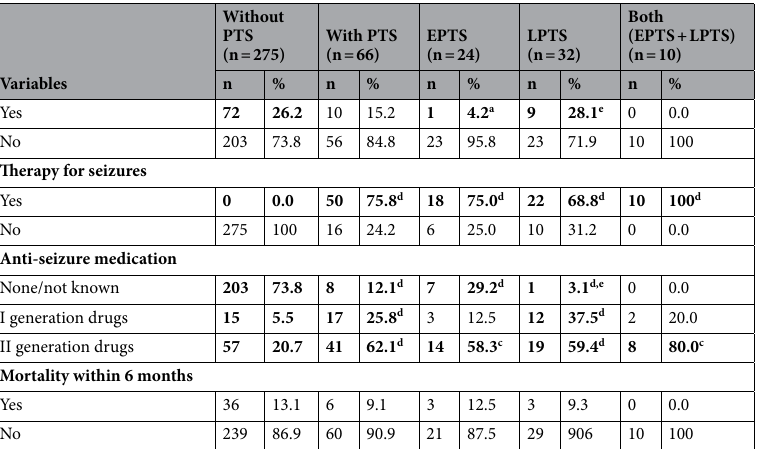
Table 2. Comparison of traumatic brain injury (TBI) patients without vs. with post-traumatic seizures (PTS), and between patients with early PTS (EPTS) vs. late PTS (LPTS) vs. both EPTS + LPTS. Data are expressed as absolute number and percentage. Comparisons between groups were performed with χ 2 test. Significant differences between patients without vs. with epilepsy or between EPTS and LPTS or both (EPTS + LPTS) are expressed as a p < 0.05, b p < 0.01, c p < 0.001, d p < 0.0001. Significant differences between patients with EPTS vs. LPTS are expressed as e p < 0.05, f p < 0.01. Significant difference are highlighted in bold.